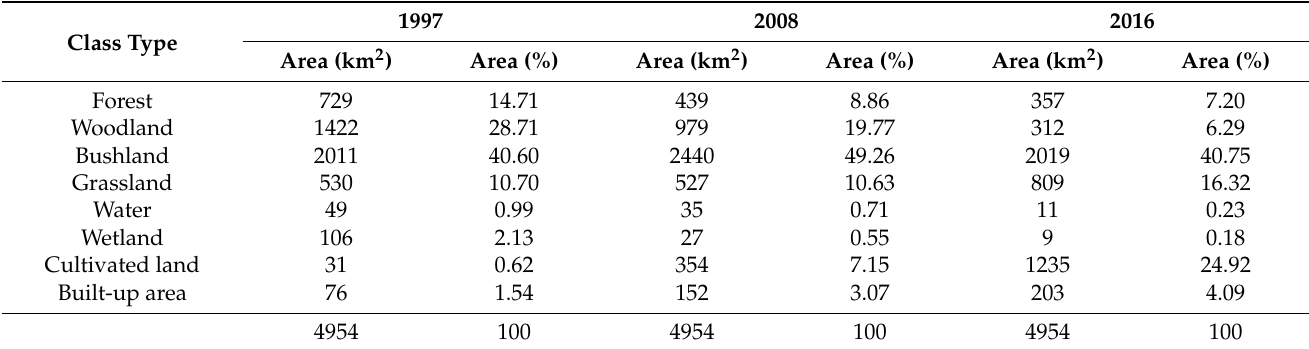
Table 4. Temporal land cover change matrix for the Kimbiji aquifer.